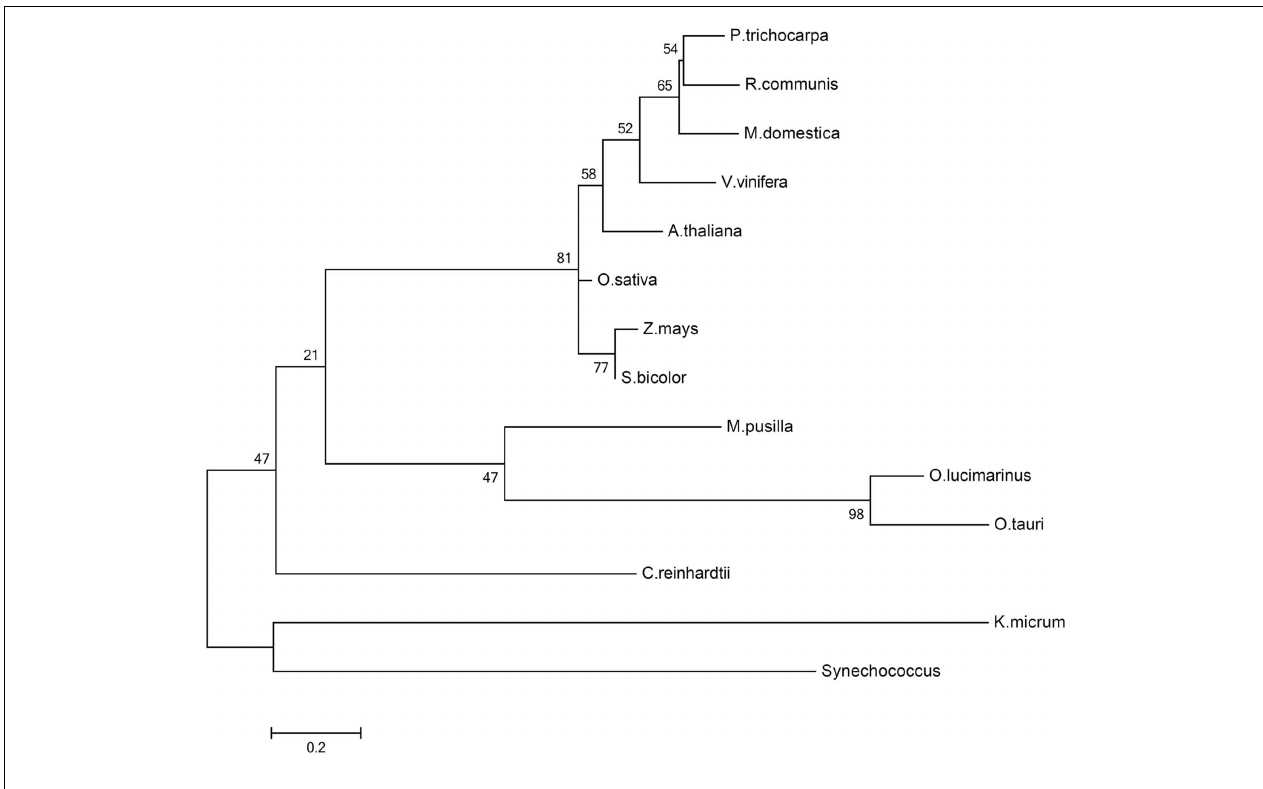
the branches. A discrete gamma distribution was used to model evolutionary rate differences among sites (five categories, + G , parameter = 3.3094).The rate variation model allowed for some sites to be evolutionarily invariable ([ + I ], 5.4532% sites).The tree is drawn to scale, with branch lengths measured in the number of substitutions per site.The analysis involved 14 amino acid sequences. All positions containing gaps and missing data were eliminated.There were a total of 173 positions in the final dataset. Evolutionary analyses were conducted in MEGA5 (Tamura et al.,